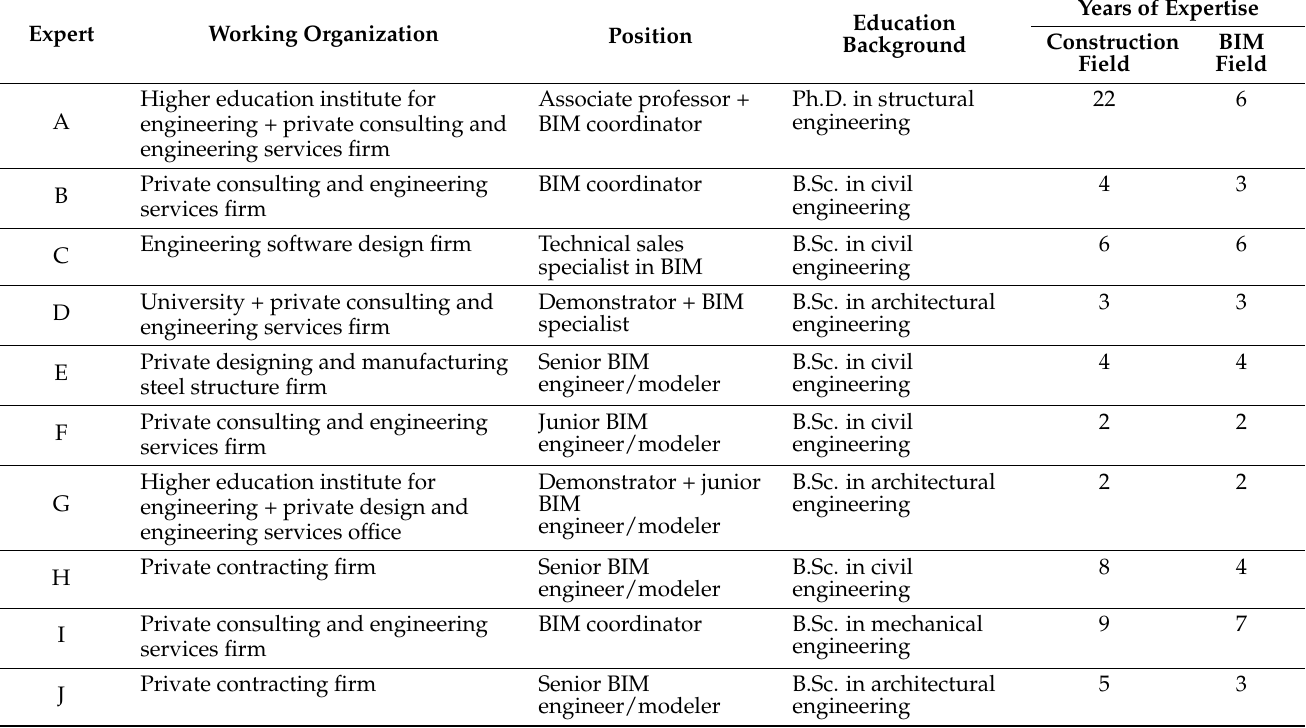
Table 3. Background of the entrants in DEMATEL questionnaire-based